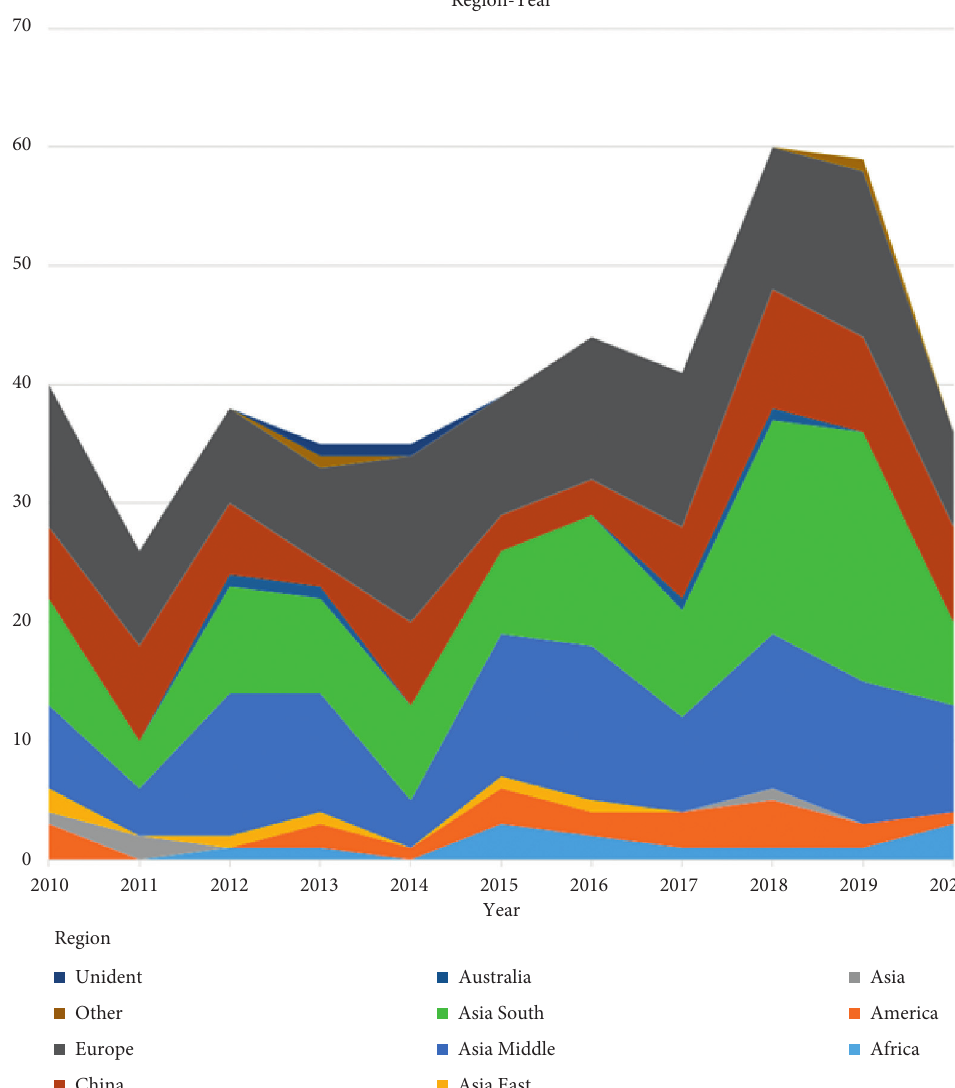
Figure 10: Crosstabulation by region and